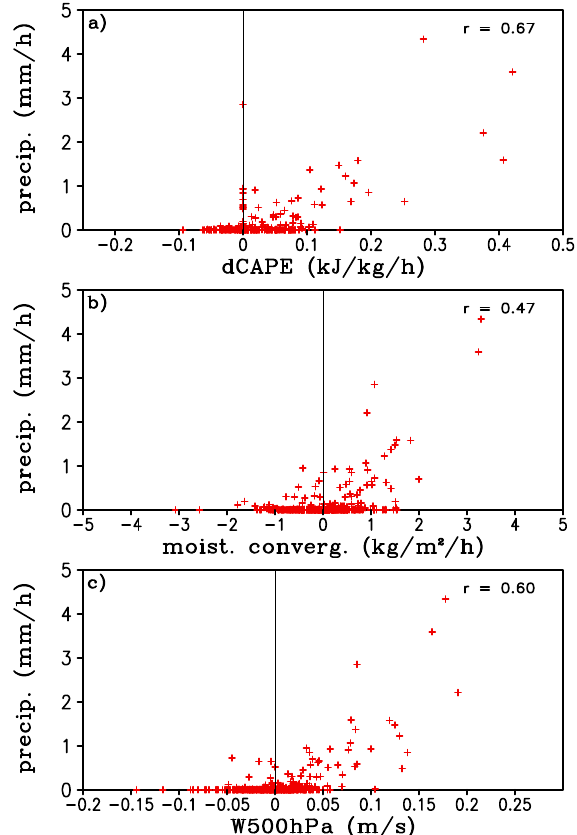
Figure 5. Scatter plots of precipitation rate (mm / h) against ( a ) large-scale convective available potential energy (CAPE) change (kJ / kg / h), ( b ) moisture convergence (kg / m 2 / h), and ( c ) vertical velocity at 500 hPa (ms − 1 ) over the 300 km MC3E variational analysis domain.